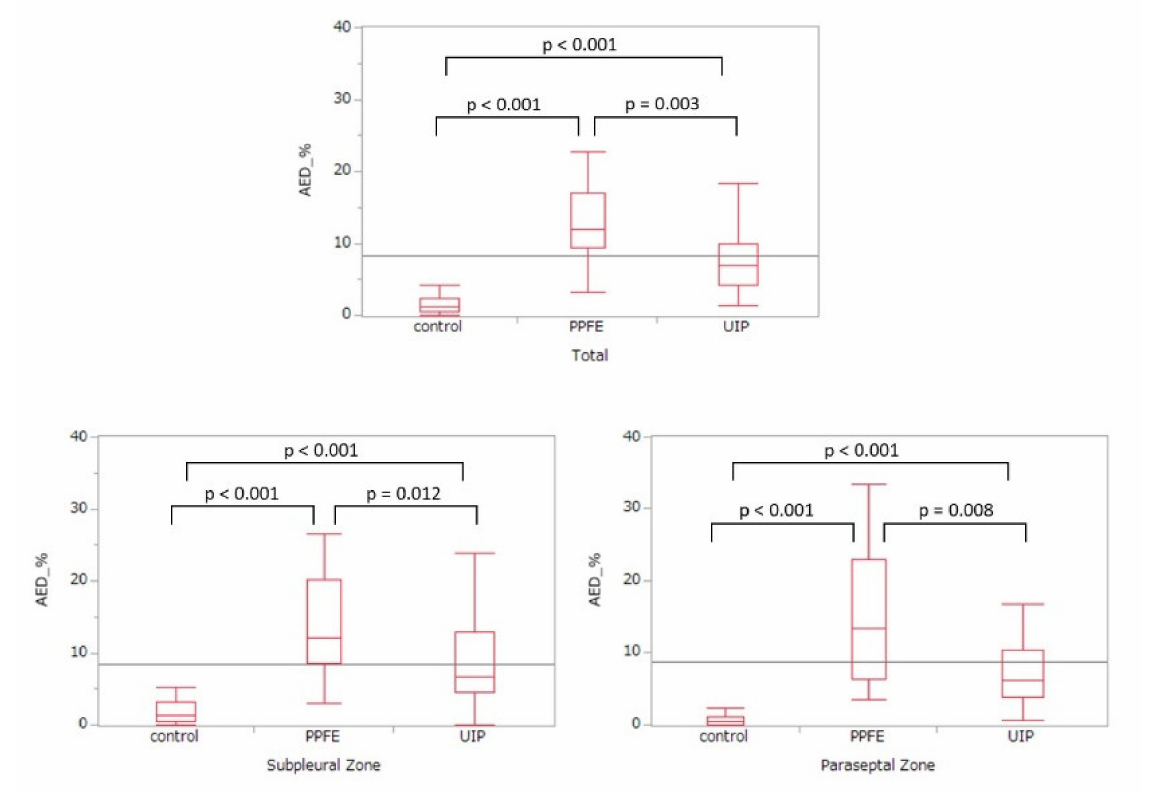
Figure 5. Percentage of alveolar epithelial denudation in each group. The lengths of continuous AEDs were examined, and a maximum of 3.52 mm and a median of 0.73 mm were found in the PPFE group. The IPF group showed a maximum of 1.44 mm and a median of 0.58 mm, which was not significantly different from the PPFE group ( p = 0.08) (Supplementary Table